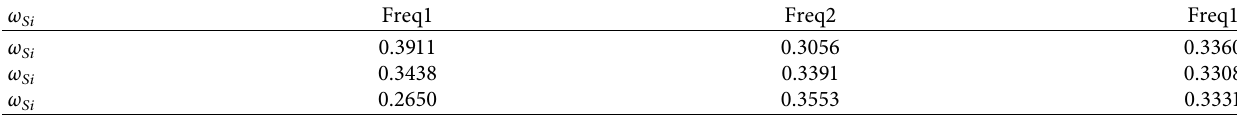
Table 7: Weighted belief entropy of sensor reports under different frequencies.